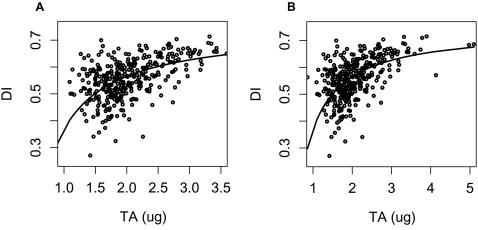
Desaturation Index DI versus total hydrocarbon abundance TA over 24 hours in LD and DD.Line is prediction from fitted multivariate linear model for the compounds used in DI calculations [33]. Predicted and actual DI values are significantly correlated (LD: Pearson's r = 0.643, p<2e-16, df = 275; DD: r = 0.529, p<2e-16, df = 346).